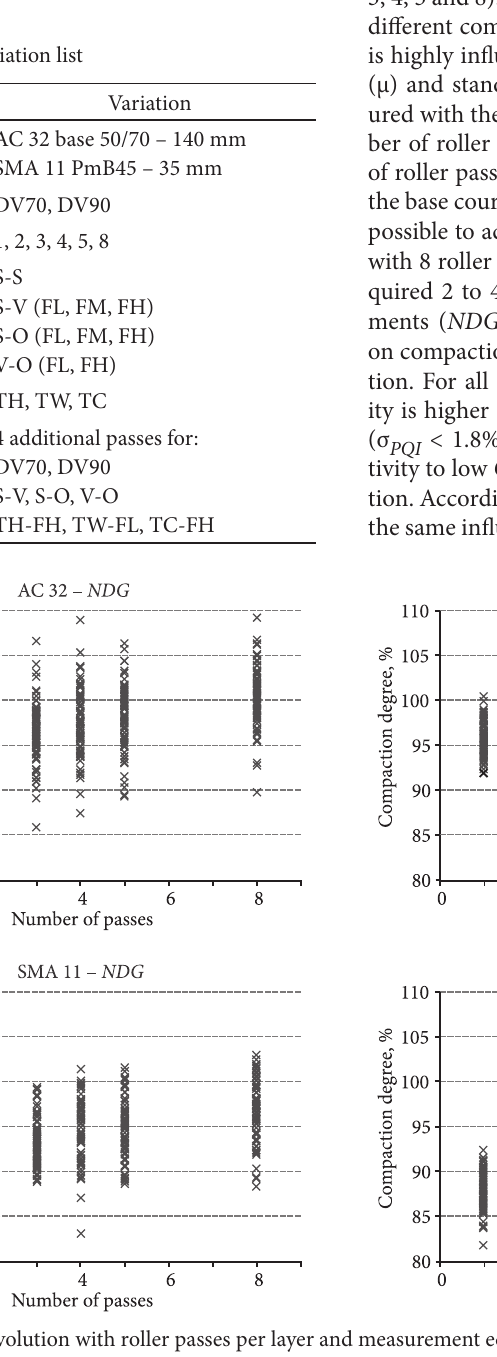
fig. 5. Compaction degree evolution with roller passes per layer and measurement